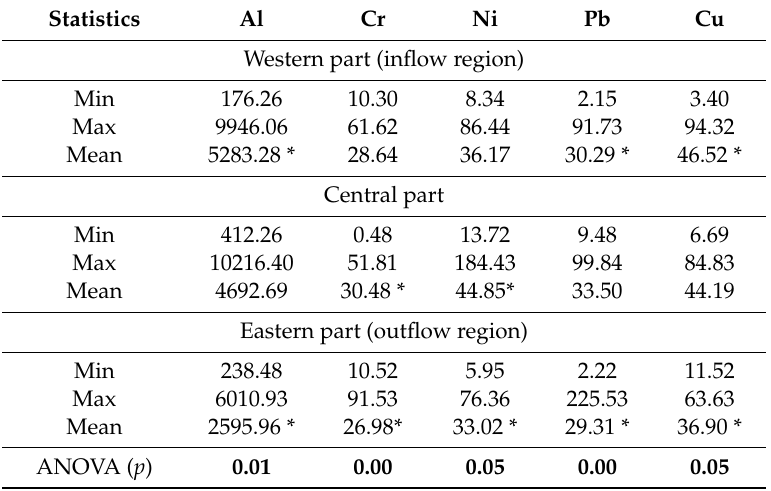
Table 4. Concentrations of major elements in sediments (mg · kg − 1 ) in 2014–2015 in the western (inflow), central, and eastern (outflow) parts of Lake Łebsko with ANOVA